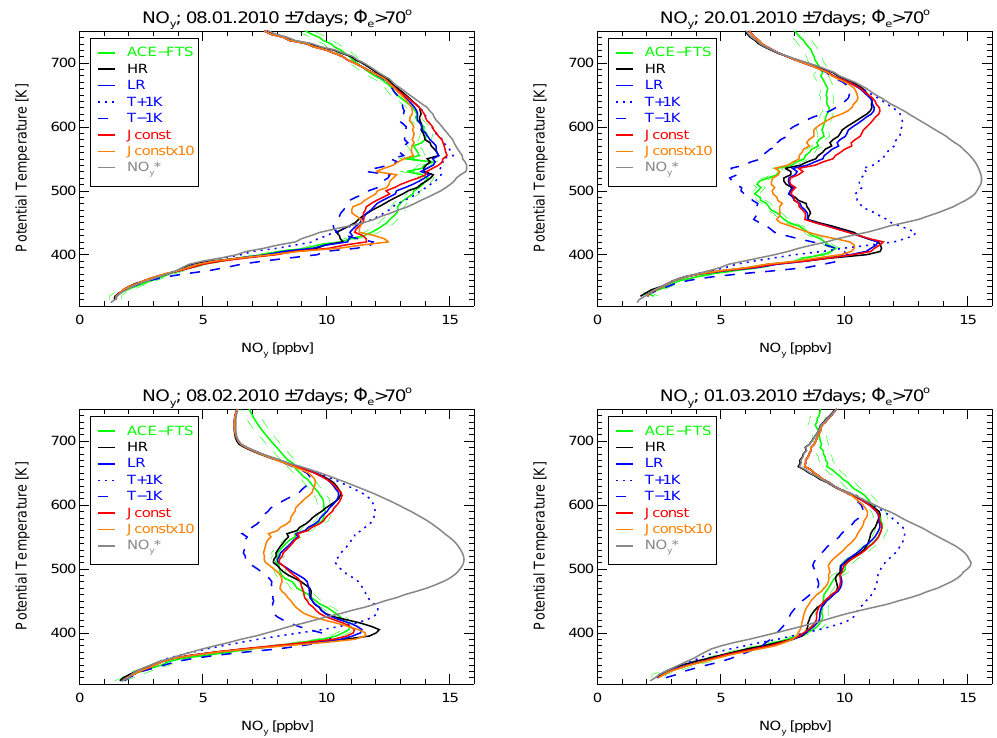
Fig. 12. Comparison of CLaMS NO y mixing ratios with ACE-FTS data. For 4 different time ranges in which ACE-FTS observations are available in northern polar latitudes, average NO y profiles from ACE-FTS inside the polar vortex core (equivalent latitudes > 70 ◦ N) are shown (green lines). The accuracy of the NO y data is indicated by the thin dashed green lines. The results for the different sensitivity simulations are indicated by the line colours and styles as in Fig. 8 For comparison, the passive NO ∗ y from CLaMS is shown as grey